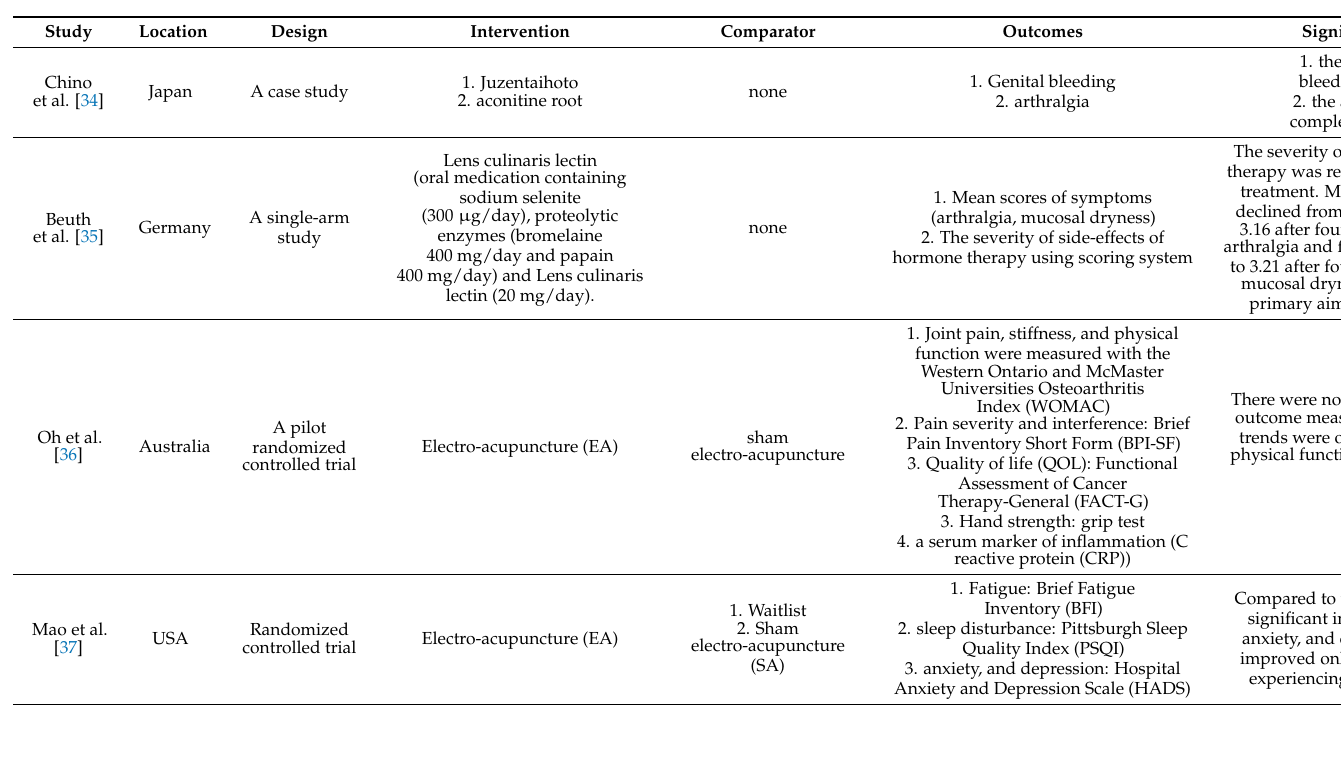
Table 4. Summary of included